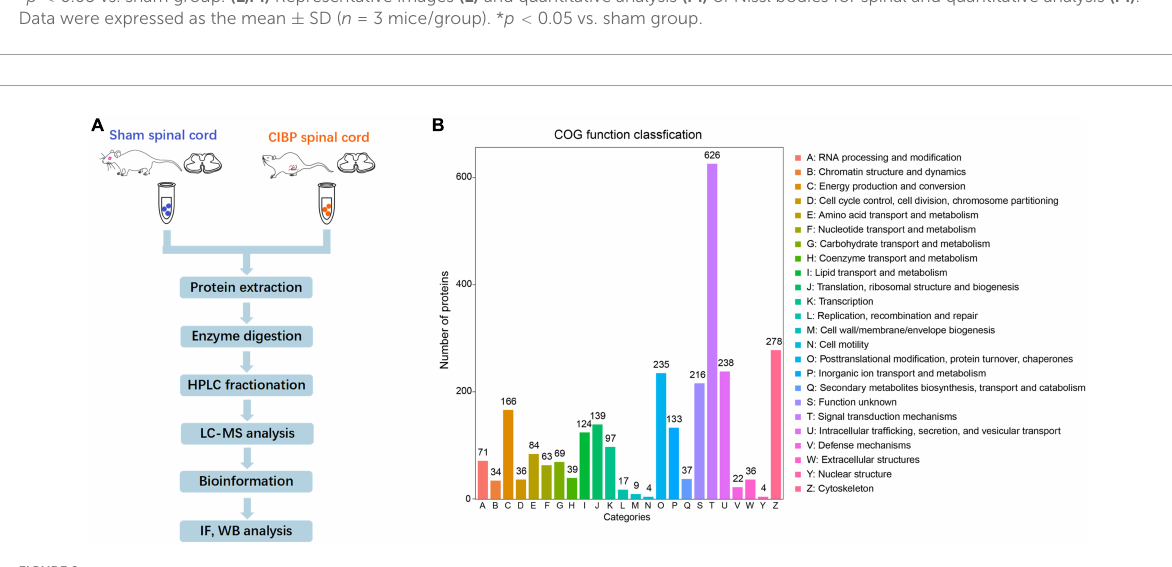
FIGURE2 Global proteomic identification in the spinal cord of sham and cancer-induced bone pain (CIBP) rats using liquid chromatography with tandem mass spectrometry (LC-MS/MS). (A) Schematic diagram of the experimental procedures. (B) Functional classification of proteins by COG. X-axis: different classifications. Y-axis: the number of proteins in each class. COG: Cluster of Orthologous Groups of